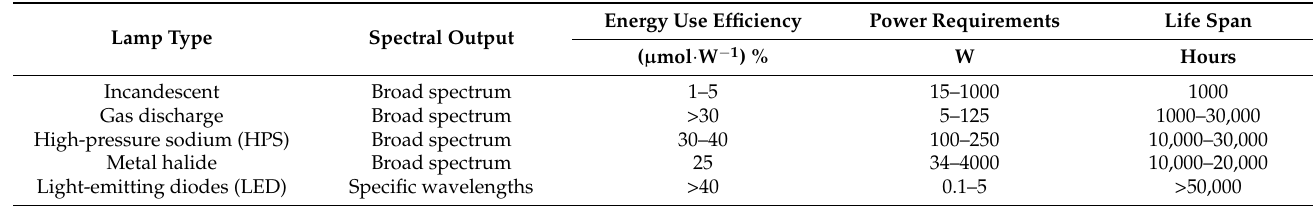
Table 1. Features of various electric lamps used for plant lighting